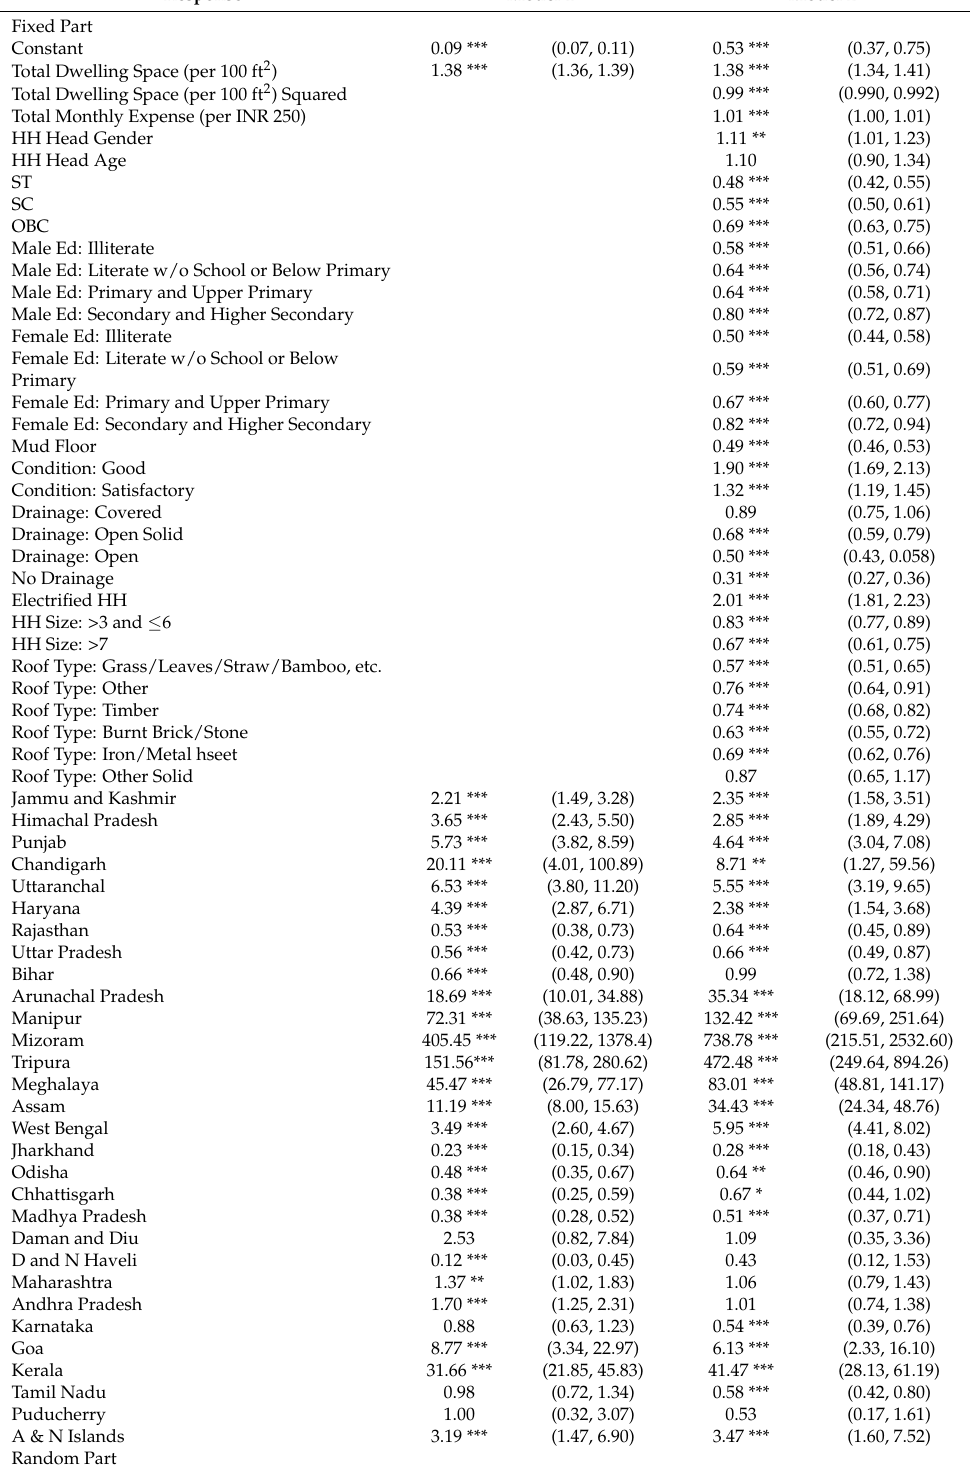
Table A1. Fixed effects results (95% CI of OR in parentheses). *** p < 0.01, ** p < 0.05, * p <